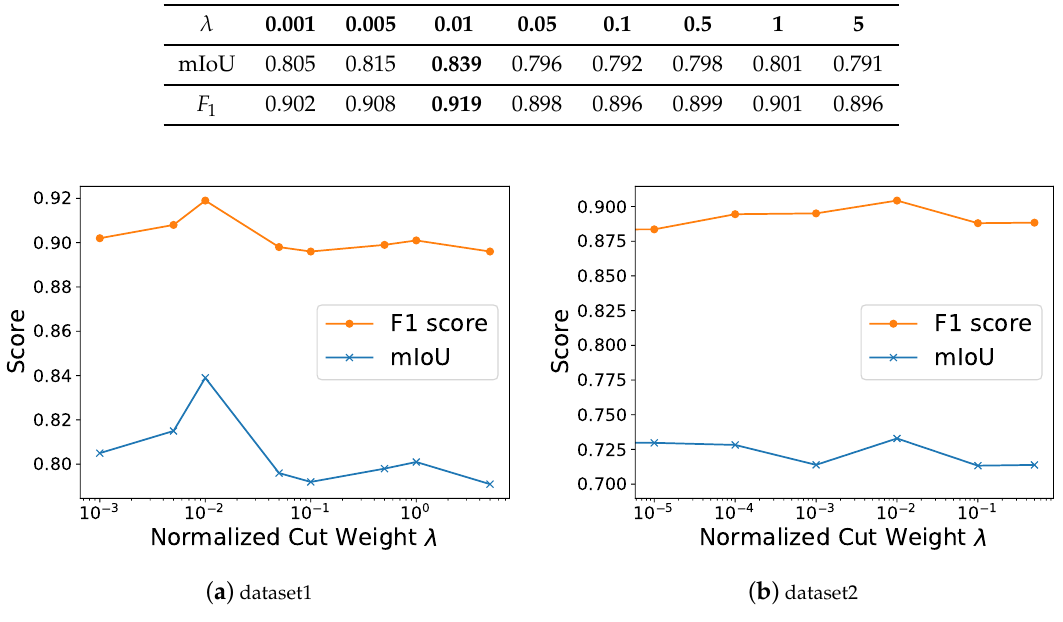
Figure 8. The F 1 score ( yellow ) and mIoU ( blue ) for different normalized cut weight λ combined with the partial loss function. ( a ) The experiment on the dataset 1; ( b ) the experiment on the dataset